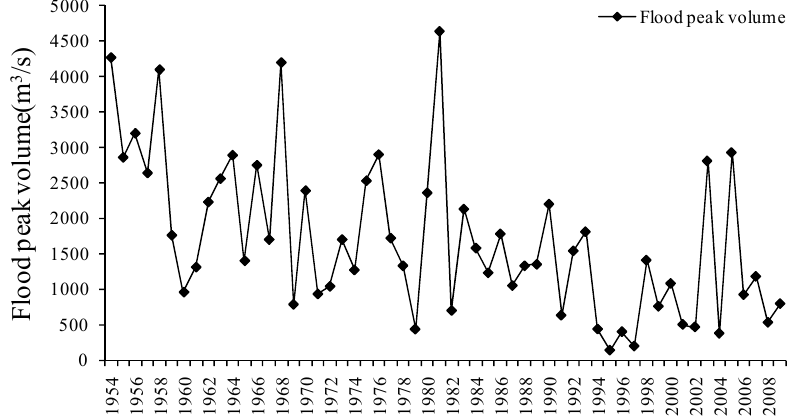
Figure 3. Annual flood peak volume of Xianyang from 1954 to 2008.